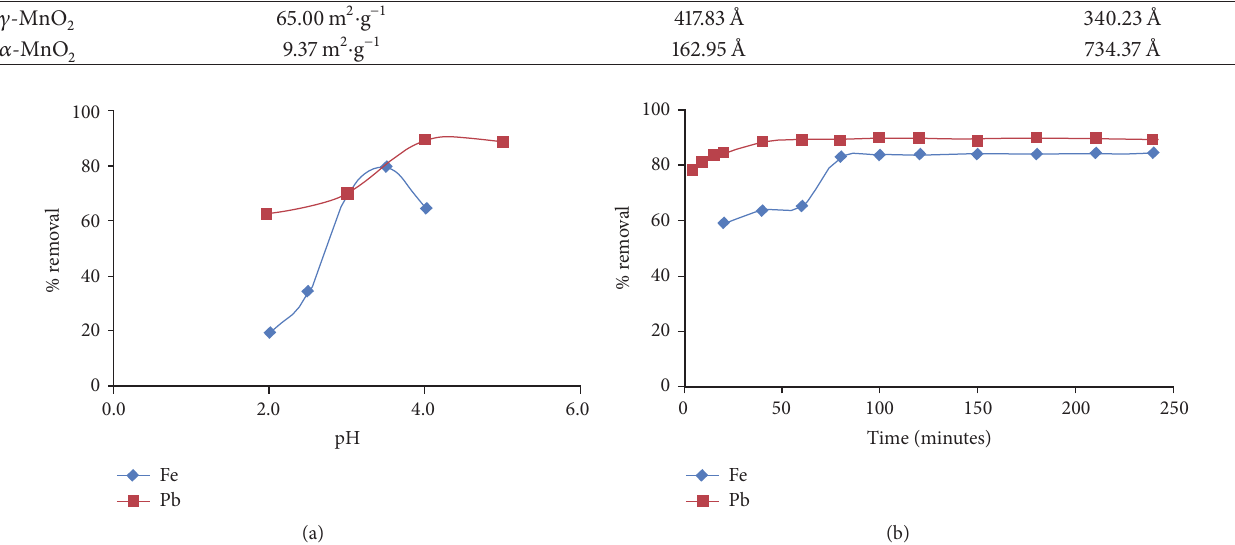
Figure 5: Influence of pH (a) and contact time (b) on adsorption of Pb(II) and Fe(III) at room temperature with 240 rpm of shaking speed.